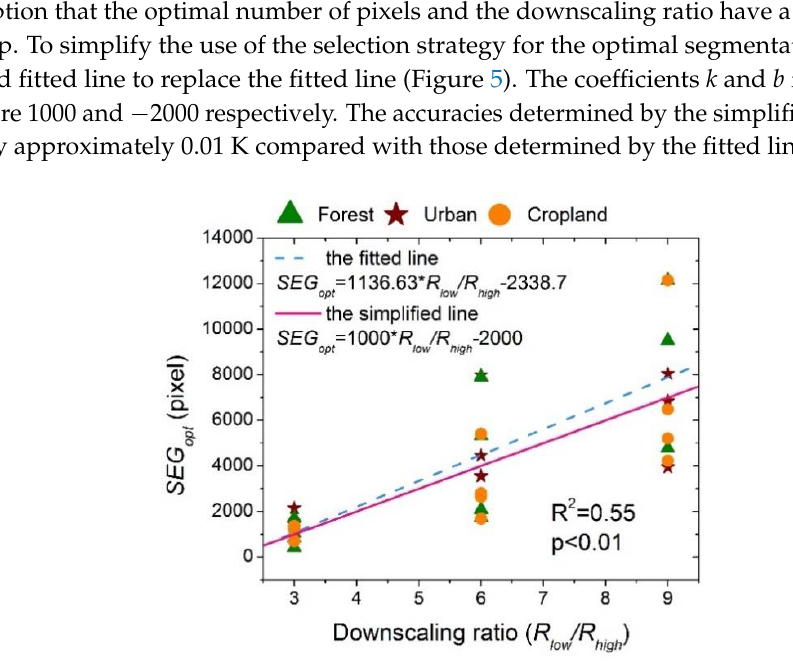
Figure 5. Correlation between the downscaling ratio and the optimal number of pixels in the object- based window.